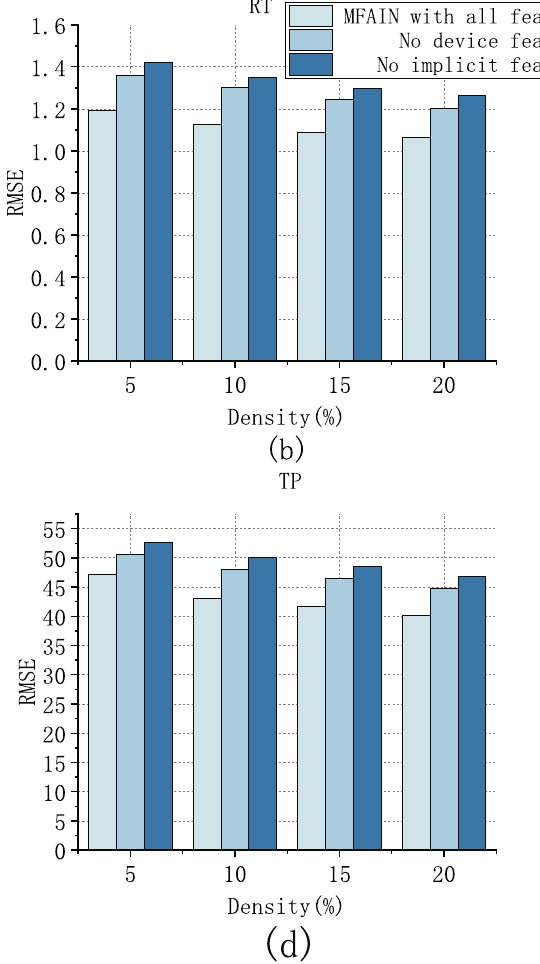
Fig. 10 The effectiveness of Implicit Feature and Device